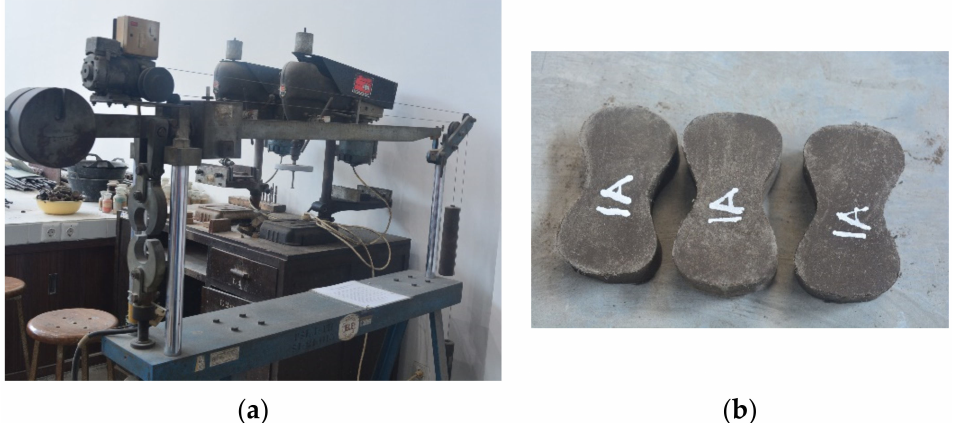
Figure 3. Tensile strength test ( a ) and the specimen ( b